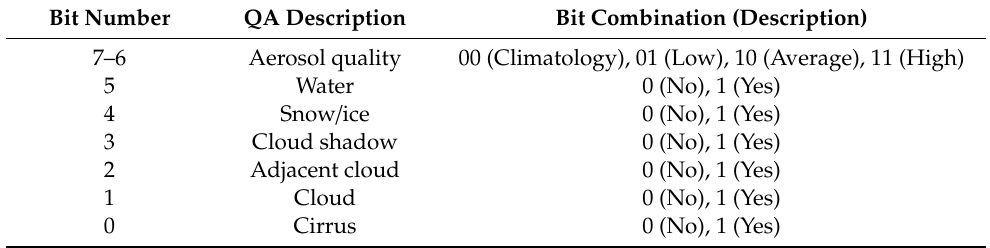
Table 2. Description of the bits in the one-byte Quality Assessment layer for the three products. Bit